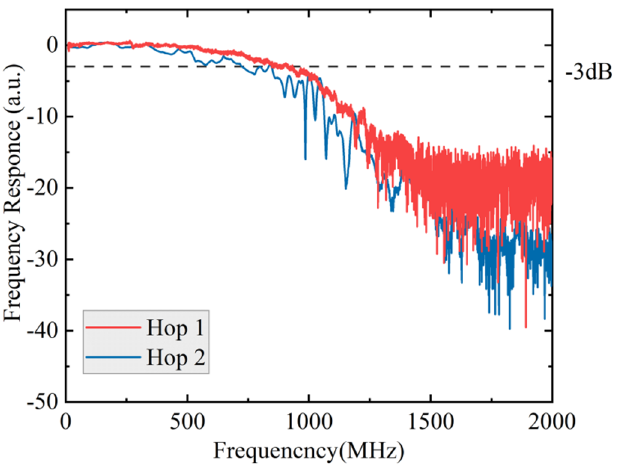
Figure 6. The comparison of measured normalized frequency response from Hop 1 and Hop 2.